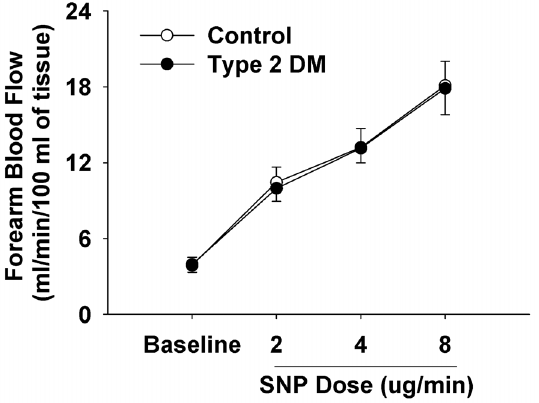
Figure 2. Forearm blood flow responses to intra-arterial sodium nitroprusside infusion in controls (n=11) and type 2 diabetic subjects (n=9). Symbols and error bars represent mean 6 SEM. Type 2 DM, subjects with type 2 diabetes mellitus; SNP, sodium nitroprusside.